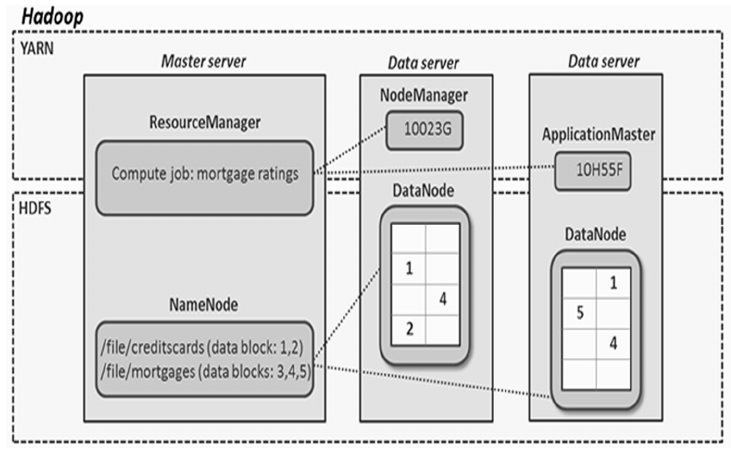
Figure 4. Functional view of Hadoop .